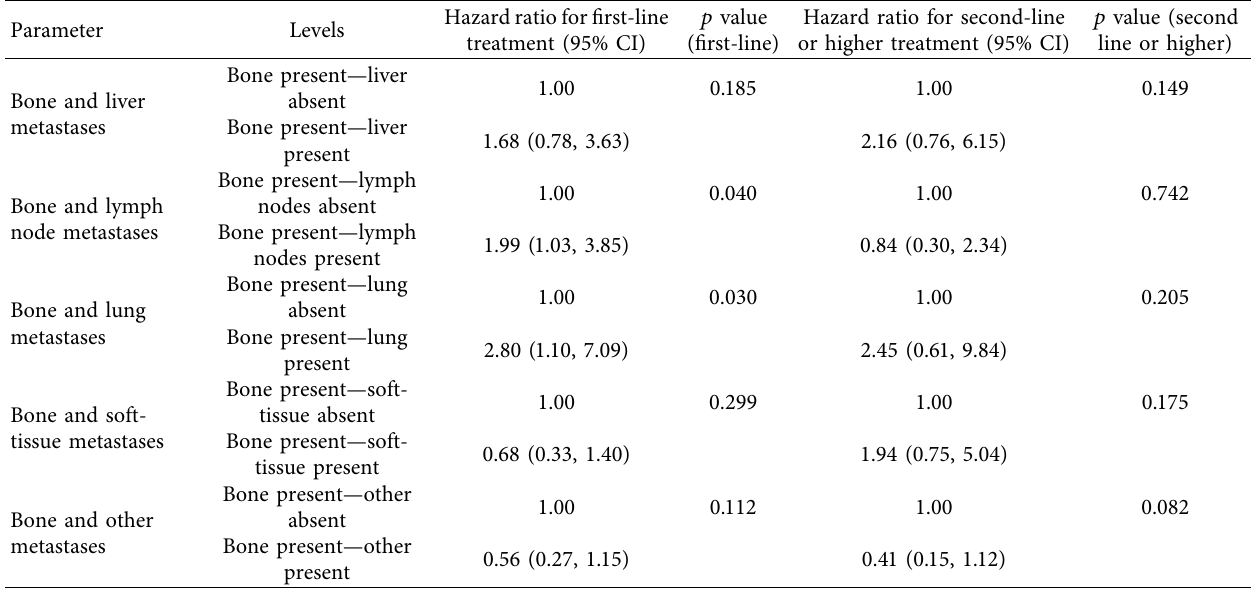
Table 6: Cox model for the effect of bone metastasis combined with another metastatic organ site on PFS stratified by study. Parameter